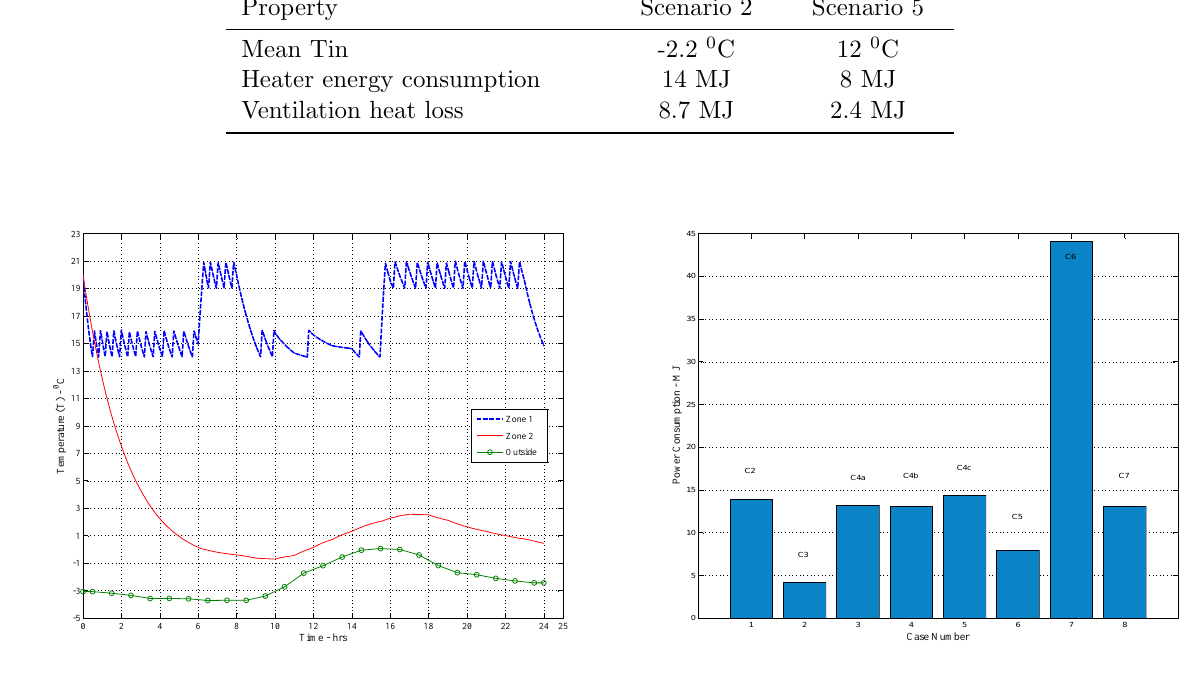
Figure 9: Temperature profiles for the two zones of the Figure 10: Power consumption of different case studies combined building highest energy consumption which constitutes a large building unit, and it is 3 times bigger than C2. A com- parison of C2 and C7 shows that the energy usage of C2 is a little higher. The reason for this is the limited heat loss through the common wall between the two zones. The driving force of heat transfer in the direc- tion of zone 2 through this wall is weak compared to the other walls because of the high temperature inside this region compared to